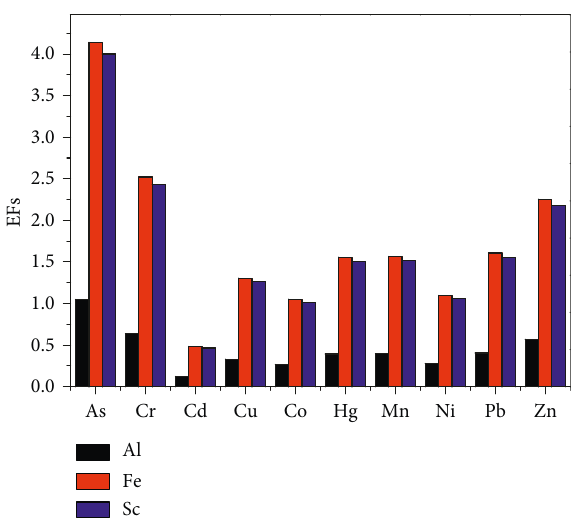
Figure 4: EF values of the heavy metals in the soils of the Aibi lake Table 2: Exposure amount of (metalloid) heavy metals for children and adults in farmland soil. ADI ing ADI inh ADI derm Children Adults Children Adults Children Adults